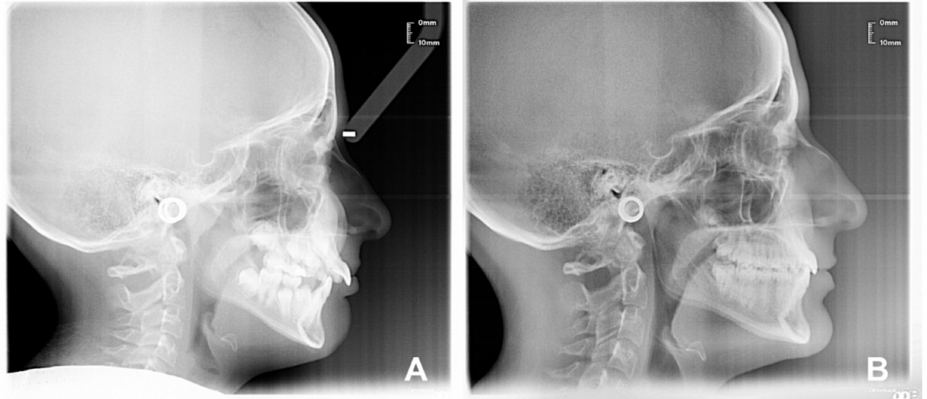
Figure 7. ( A , B )—Patient (D.L.) latero-lateral teleradiography X-ray: before treatment T0 ( A ) and after treatment T1 ( B